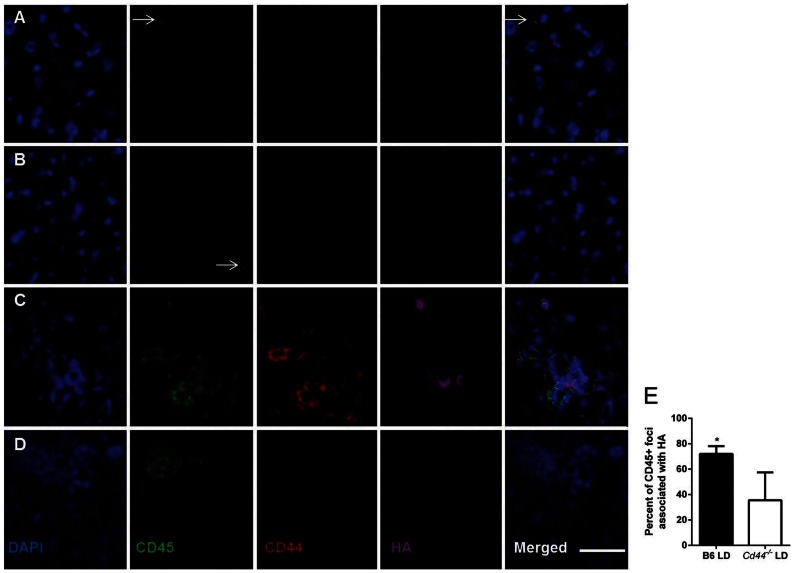
Leukocytes co-localize with HA in B6 diet fed mice.(A) B6 mice fed SD and (B) Ccr2−/− mice fed LD display rare CD45+ inflammatory cells (white arrows). (C) After 4 weeks of LD feeding B6 mice develop marked foci of CD45+ CD44+ cells that are often co-localized with HA expressing regions of the liver. (D) In contrast, Cd44−/− mice develop CD45+ inflammation without CD44 expression and decreased co-localization with HA. (E) Quantitative assessment of co-localization of HA with inflammatory foci demonstrates a high degree of co-localization in B6 mice and a moderate amount in Cd44−/− mice. CD45+ inflammatory foci were counted and scored positive if clusters of CD45+ cells occurred in direct contact with HA positive staining. Inflammatory foci were not identified in Ccr2−/− and SD fed mice and as a result they were not quantified. (*P<0.05, data represent counts analyzed by contingency tables and Fisher’s exact test from n = 4 mice per group).